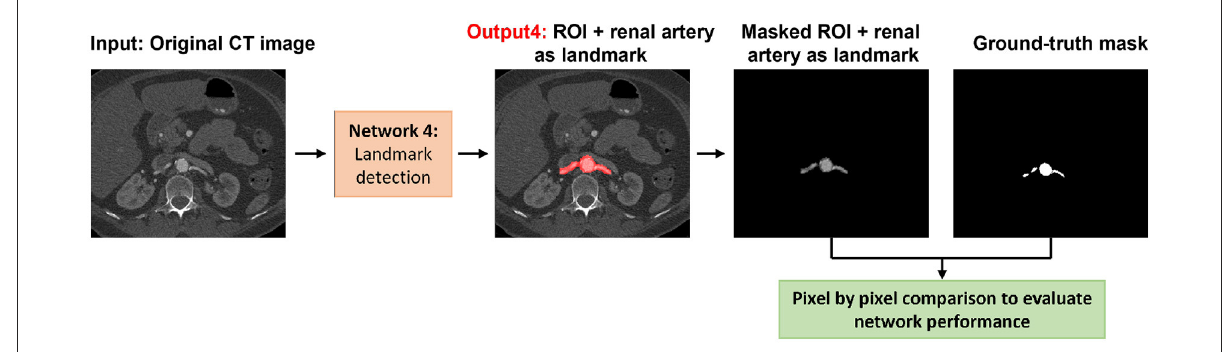
FIGURE4 Visual representation of the landmark detection including the detection of the aorta, iliac, celiac, and renal arteries.